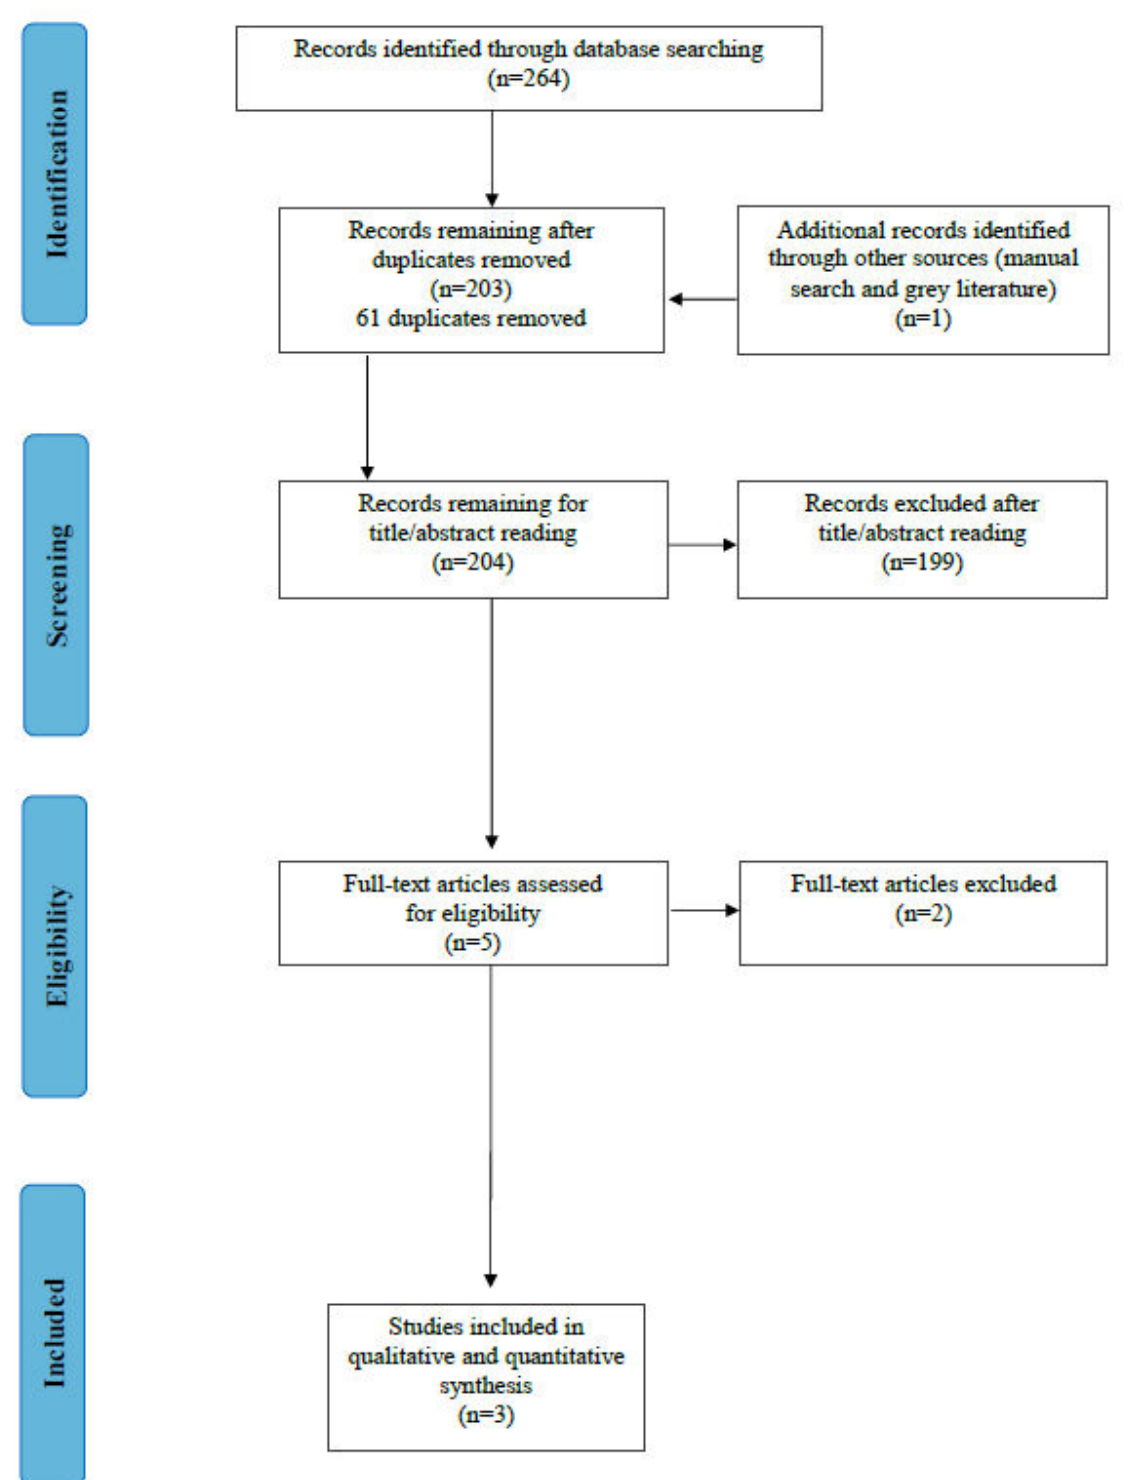
Figure 1. Flow diagram (PRISMA format) of the screening and selection